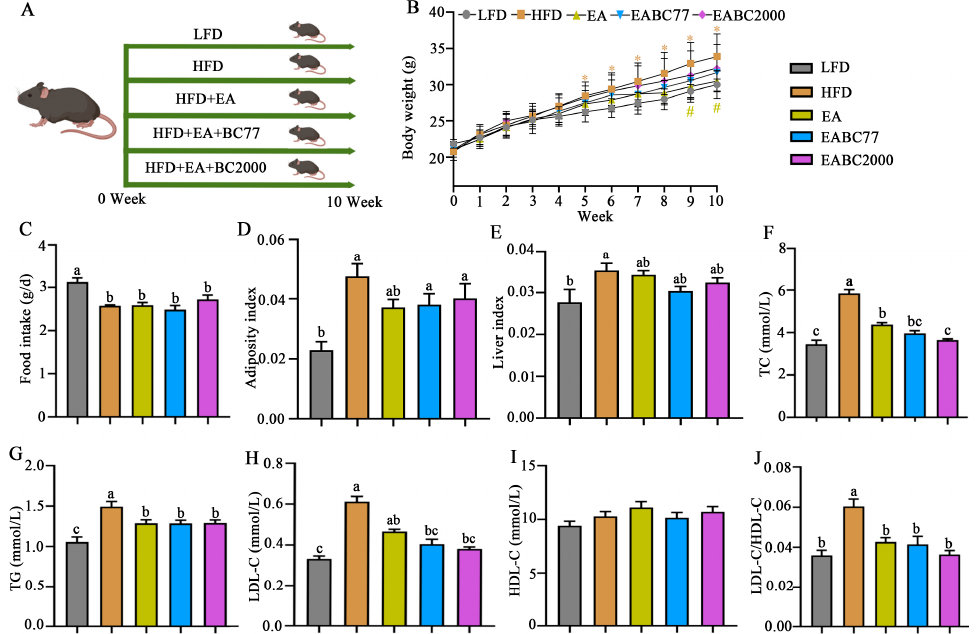
Figure 1. Effect of jointly consuming Weizmannia coagulans BC2000 and ellagic acid on lipid metabolism of mice. ( A ) Design of experiment; ( B ) body weight; ( C ) food intake; ( D ) adiposity index; ( E ) liver index; ( F ) TC; ( G ) TG; ( H ) LDL-C; ( I ) HDL-C; ( J ) LDL-C/HDL-C. * indicates a signifi- cant difference compared to the LFD group ( p < 0.05); # indicates a significant difference compared to the HFD group ( p < 0.05). n = 10 in each group. Different letters indicate significant differences be-